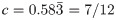
Front propagation in secondary tauopathy; brain connectome.Each subfigure consists of a toxic Aβ concentration distribution (subfigure left) besides a toxic τP concentration distribution (subfigure right). Dark blue indicates the minimum concentration of c = 0.0 while bright red indicates the maximum of c = 0.5 for toxic Aβ and c=0.583¯=7/12 for toxic τP. (See also: supplementary S4 Video and supplementary S2 Data).